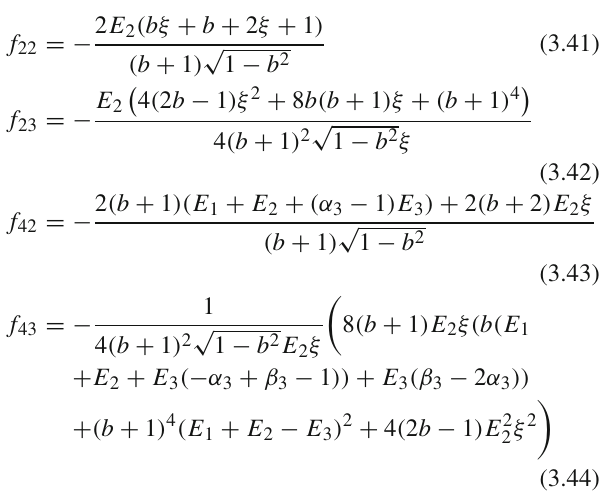
Fig. 6 The contour map of E 3 in terms of α 3 and s 1 . The time-like condition for the particle 3 is satisfied in the light-green shaded region with different b . The maximum value of E 3 is obtained at the red point.